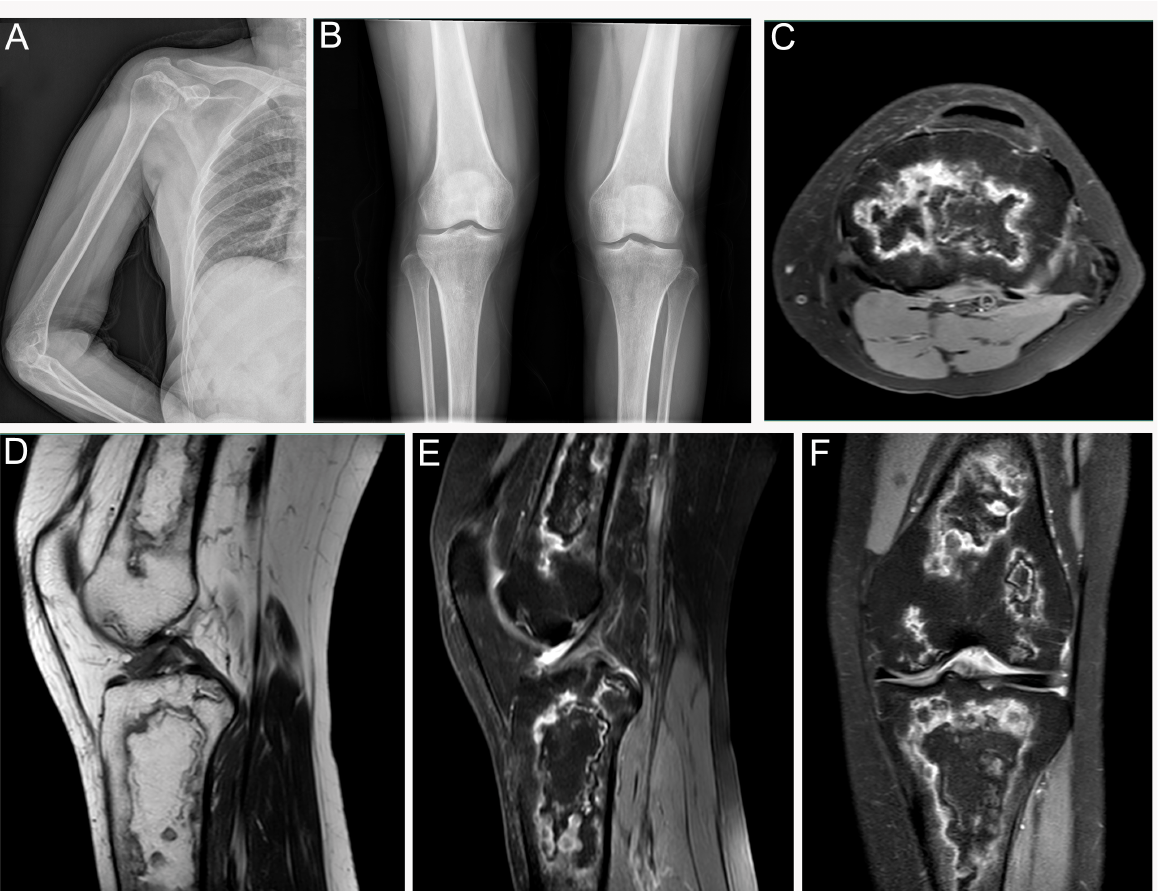
Figure 4. Patient 3: ( A , B ) X-ray films of the right upper extremity and knee joints. ( C – F ) Sagittal T1-weighted image of left knee showed irregular low-SI areas with low-SI margins. Edema zone surrounding infarcted bone of knee joint presented high SI on transverse, sagittal, and coronal T2-weighted fat-suppressed